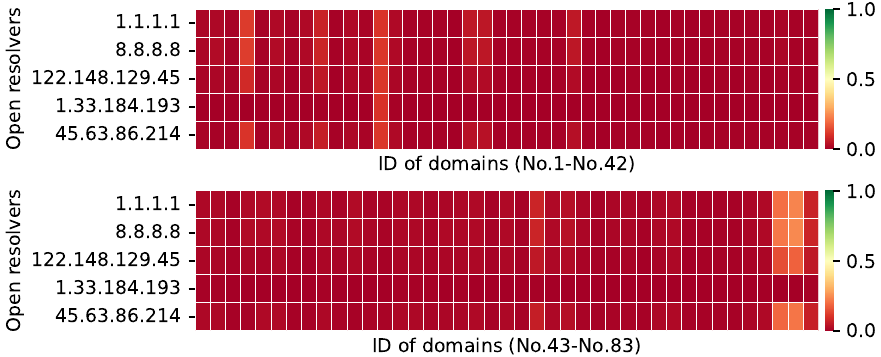
Figure 6. The ACR of each non-Chinese public resolver for blocked domains from